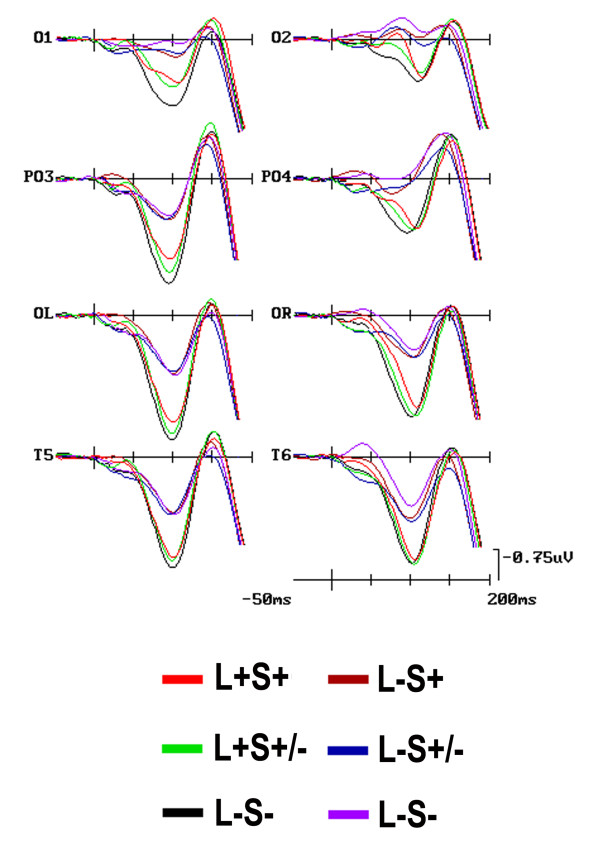
ERP waveforms at left and right mesial-occipital, occipital-parietal, lateral-occipital, and occipital-temporal electrodes grand-averaged across participants as a function of the conjoined spatial and non-spatial relevance of shape-pairs (i.e., L+S-, L+S+/-, and L+S-, as well as L-S+, L-S+/-, and L-S-). Whereas C1 was of greater amplitude over mesial occipital sites, P1 response was larger over lateral occipital sites. Scaling is the same as for Figures 2 and 3.